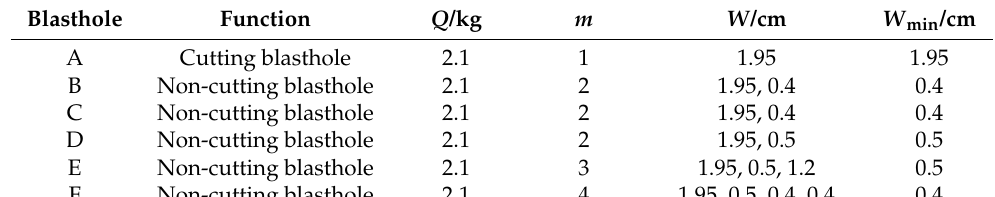
Table 1. Table of blasting parameters.